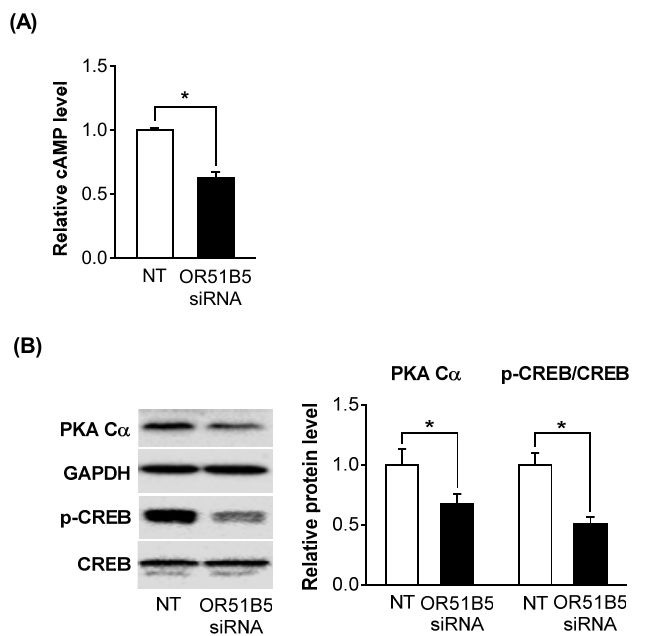
Figure 6. OR51B5 knockdown inhibits the olfactory signaling pathway in Hs68 cells. ( A ) Intracellular cyclic adenosine monophosphate (cAMP) levels were determined by cAMP ELISA kit after transfection with non ‐ targeting siRNA (NT) or OR51B5 ‐ specific siRNA #2. ( B ) Protein expression of protein kinase A catalytic subunit (PKA C α ), glyceraldehyde 3 ‐ phosphate dehydrogenase (GAPDH), phosphorylated cAMP ‐ response element ‐ binding protein (p ‐ CREB), and CREB was determined by Western blot. Results are expressed as mean ± SEM of three independent experiments. * p < 0.05. 2.7. OR51B5 Knockdown Decreased Cell Survival ‐ Related Gene Expression in Hs68 Cells To investigate whether OR51B5 knockdown ‐ induced cell growth inhibition is associated with cell survival ‐ related genes, we first selected 34 cell survival ‐ related genes transcriptionally regulated by CREB [27–29]. Thereafter, we evaluated their expression in NT ‐ or OR51B5 siRNA #2 ‐ transfected Hs68 cells. Among these, the gene expression of three genes including ribosomal protein s6 ( RPS6 ), transferrin receptor ( TFRC ), and tumor protein, translationally ‐ controlled 1 ( TPT1 ) was significantly lower after OR51B5 siRNA transfection than that after NT transfection (Figure 7).